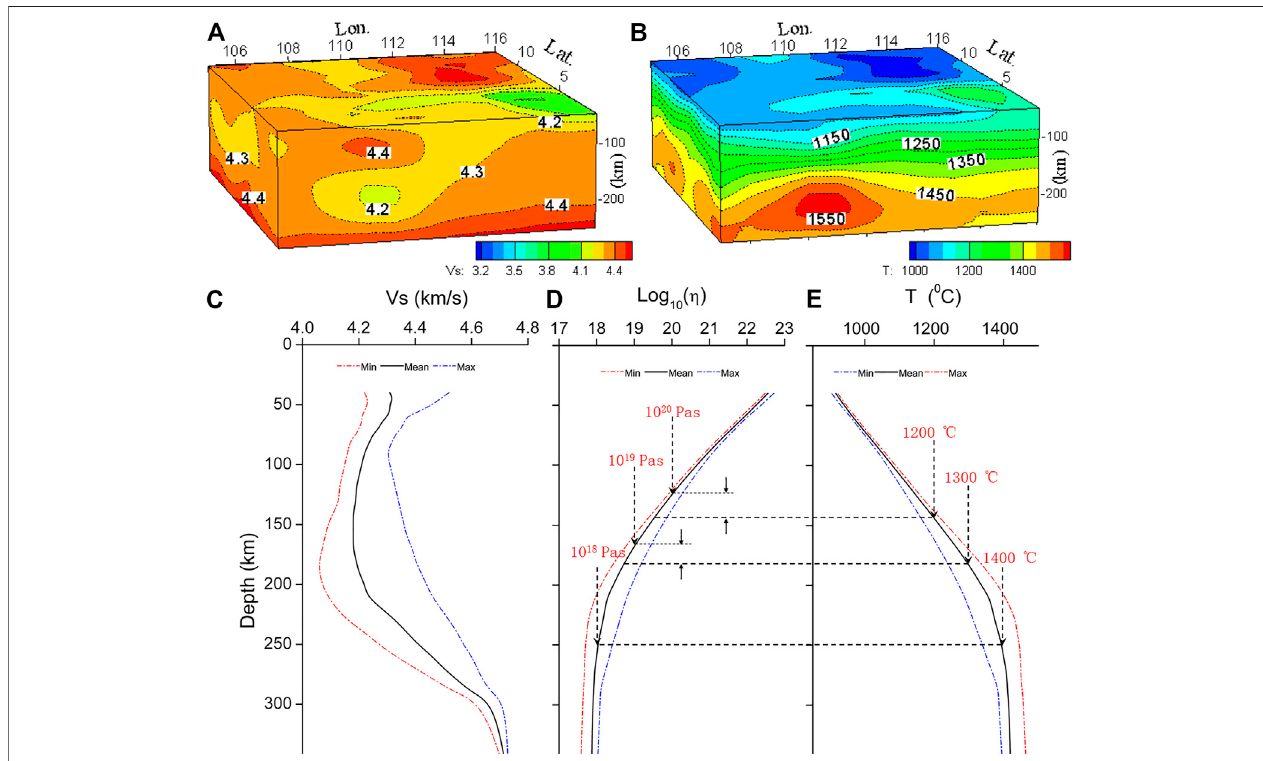
FIGURE 6 | Diagram of the S-wave velocity characteristics and dynamic analysis of the mantle in the southwestern margin of SCS. (A) S-wave velocity 3D model (km/s). (B) Temperature chart (50 – 250 km) calculated by wave velocity model ( ° C). (C) Average S-wave velocity structure varying with depth. (D) Logarithm of the effective viscosity coef fi cient of the mantle with variations at depth. (E) Mantle temperature varying with depth.